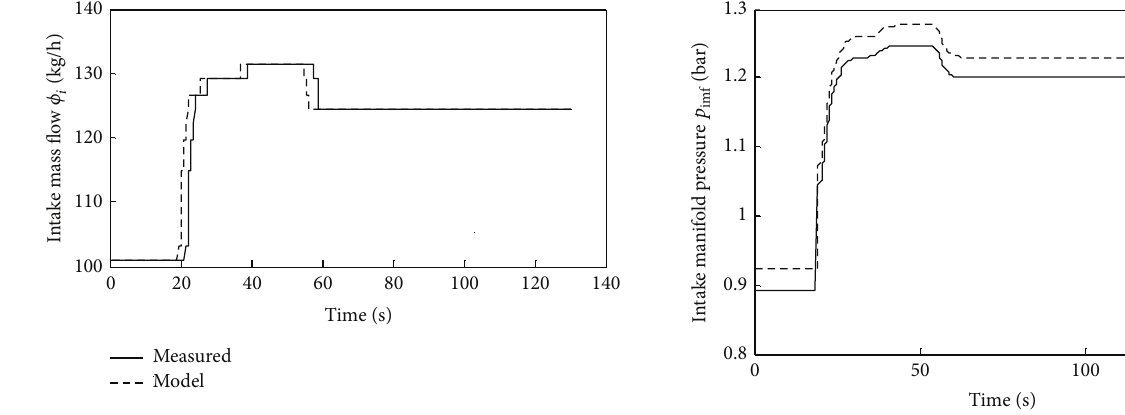
Figure 20: Measured and modeled results of intake air mass flow.